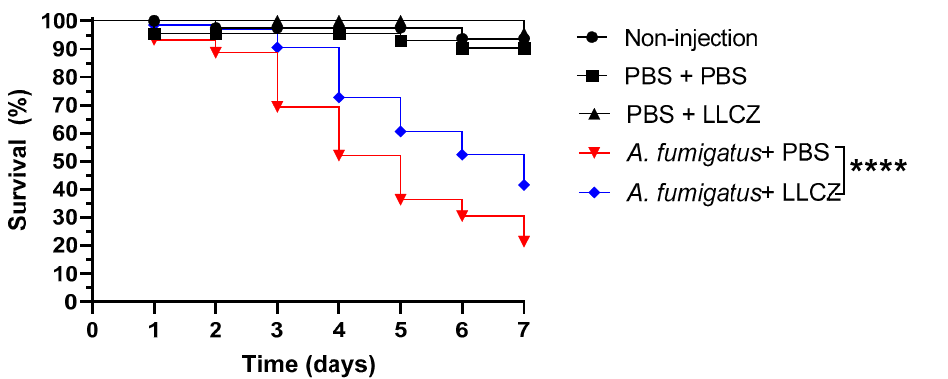
Figure 5. Survival curves for Galleria mellonella larvae treated with placebo (PBS) and LLCZ during a seven-day period. Groups of 15 larvae were injected with a fungal inoculum of 2.5 × 10 5 CFU/mL and then after 24 h with 152 mg/L LLCZ (treatment) or PBS (placebo). Control groups were initially injected with PBS and with either PBS or LLCZ on the second day, in order to rule out any false- positive results caused by the piercing damage of the needle or by LLCZ. A non-injection control was used as an indicator for the quality of the larvae. The larvae were incubated at 37 °C and mortality was checked every 24 h for at least 7 days. Results shown are the average values for all of the three isolates (1954, 2107, and the wild type). Statistical significance was determined by Dunnett’s multiple comparison tests. ****: p < 0.0001.